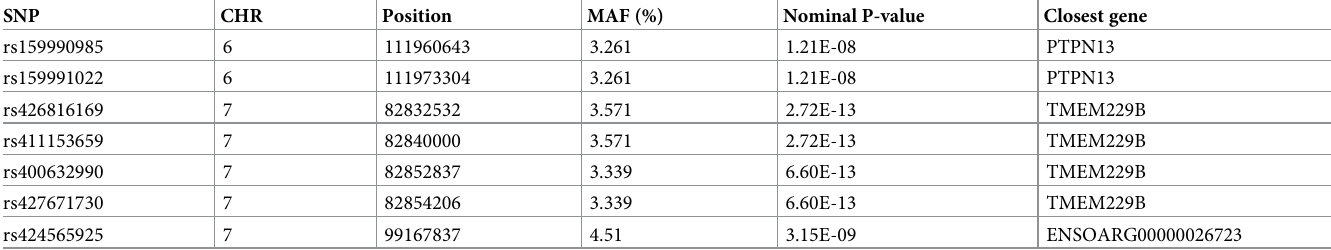
Table 2. Significant SNPs associated with untransformed M . ovipneumoniae mean DNA copy number in the all-breed analysis.